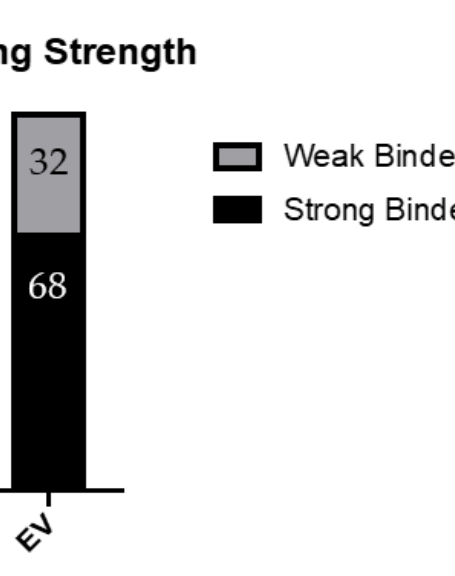
Figure 3. Predicted binding affinities for cell surface (CL) and extracellular vesicle (EV) HLA-I peptides isolated from cancer cells lines. Based on predicted binding affinity by NetMHCpan 4.0 [28], HLA-I peptides were classified as strong binder (binding affinity less than 100 nM) or weak binders (binding affinity over 100 nM and up to 1000 nM) and the percentage of strong and weak binding peptides were plotted for both the cell and EV HLA-I ligandomes. The numbers in the columns indicate the percentages of each subset. The EV HLA-I peptide pool contained more peptides with predicted strong binding affinities compared to the cell surface HLA-I peptide pool.